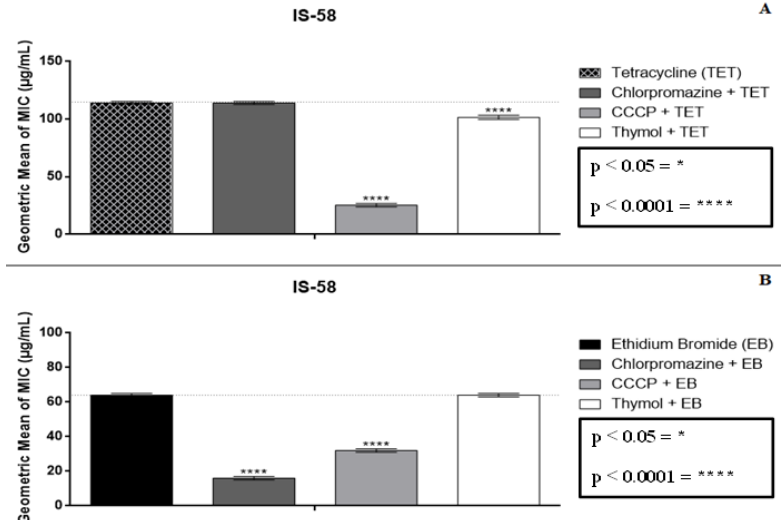
Figure 1. Effect of the association between thymol and tetracycline ( A ) and thymol and ethidium bromide ( B ) over S. aureus IS-58, expressing the TetK efflux protein. CCCP = carbonyl cyanide m-chlorophenylhydrazone; * p < 0.05; **** p < 0.0001.